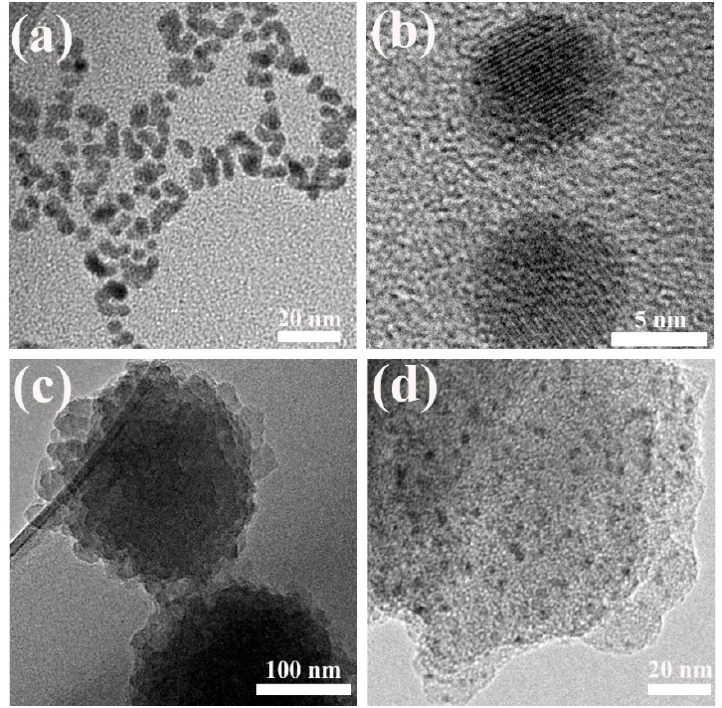
Figure 2. ( a , b ) TEM images of AuNPs under different magnification; ( c , d ) TEM images of AuNPs@ COF TFPB-NBPDA under different magnification. COF TFPB-NBPDA under different magnification.